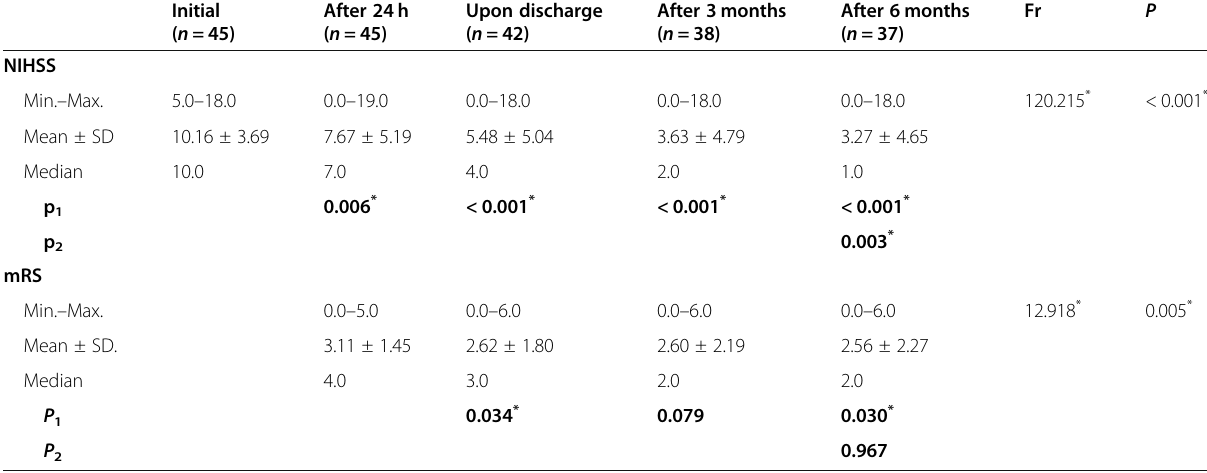
Table 3 Comparison between the different periods according to NIHSS and mRS throughout the follow-up duration